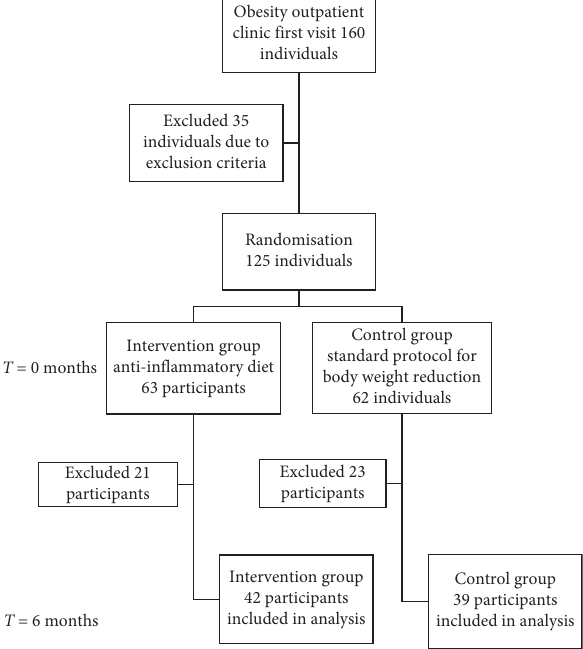
Figure 1: The flowchart of participants in the study